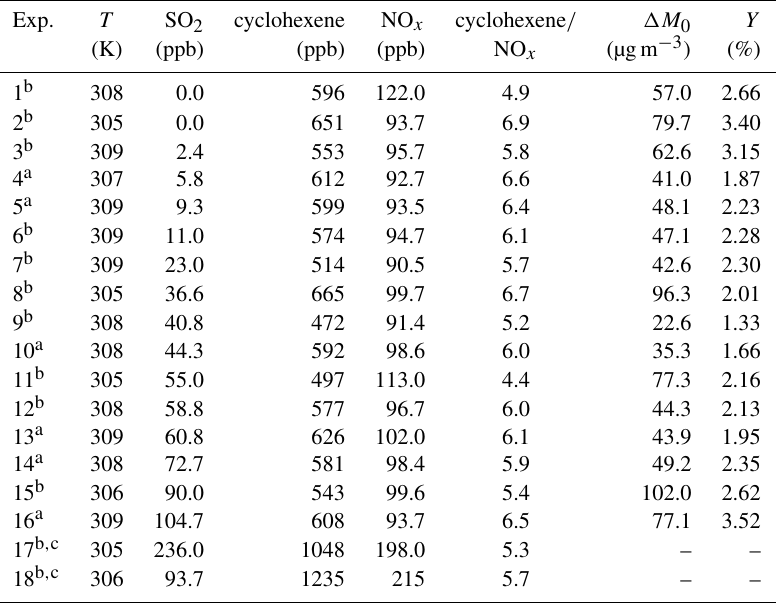
Table 1. Experimental conditions for the photooxidation of a cyclohexene / NO x / SO 2 system. All experiments were performed under dry conditions (relative humidity<10%). (cid:49)M 0 is the produced organic aerosol mass concentration, and Y is the SOA yield.